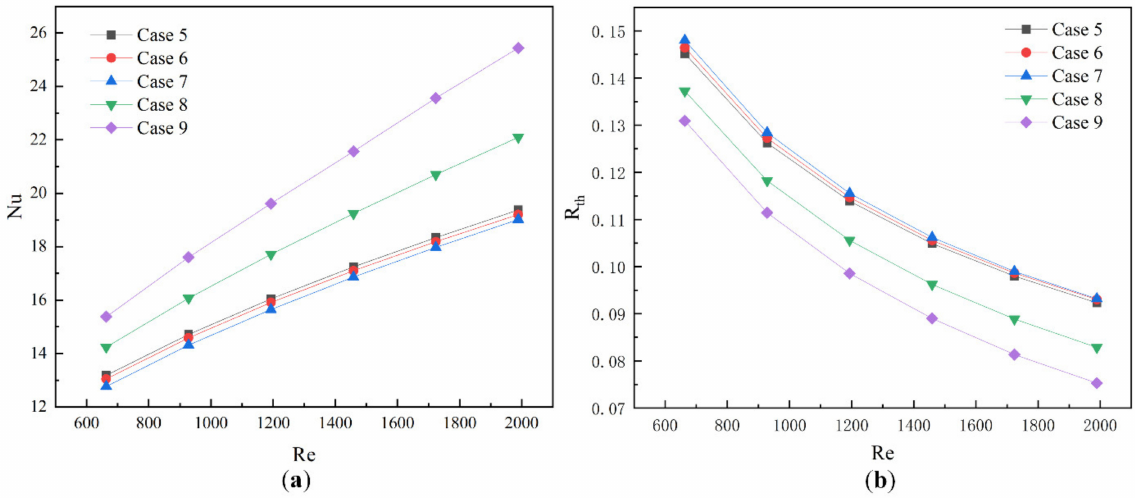
Figure 14. Data diagram of Case 5-9; ( a ) Nusselt number at different Reynolds numbers; ( b ) thermal resistance at different Reynolds